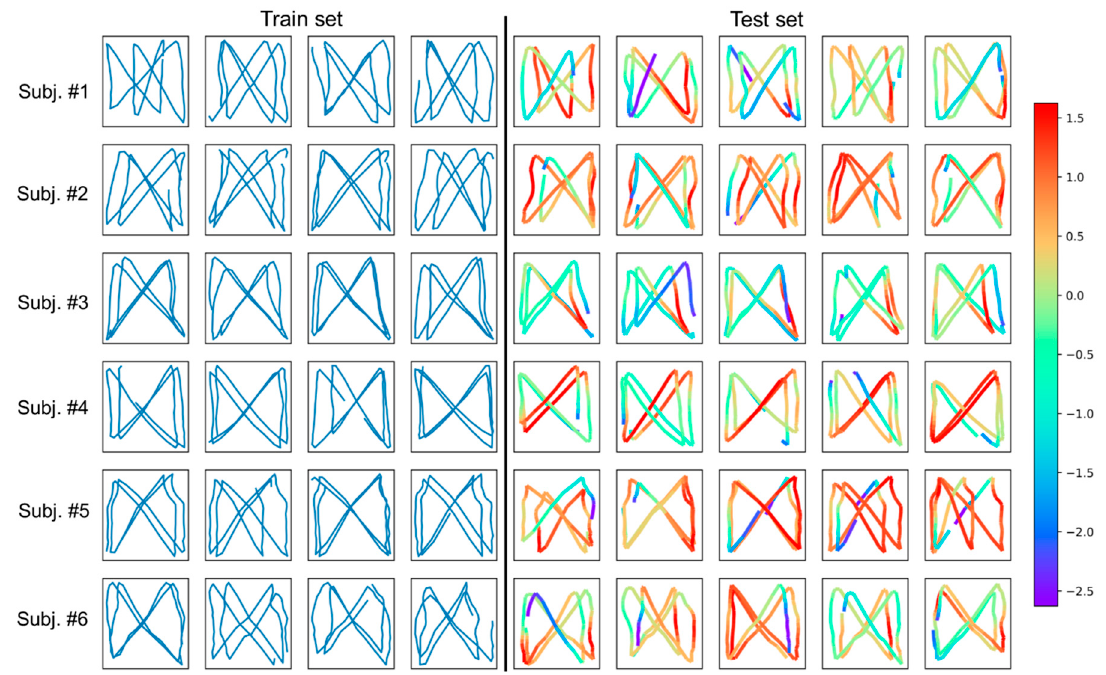
Figure 6. Class activation mapping (CAM) analysis. Twenty-four segments were randomly selected from the training set containing the gait data of six participants (left columns). These segments were used to fine-tune the last layers of the convolutional neural network (CNN) that was pre-trained on the training set of the 30 other participants. This CNN classified 30 segments drawn randomly from the test set with 100% accuracy (right columns). Class activation mapping (CAM) was performed on each sample of the test set. Color coding shows which parts of the signals are prioritized to be used by the CNN to perform classification. Warm colors (red, orange): high focus; cold colors (green, blue): low focus.